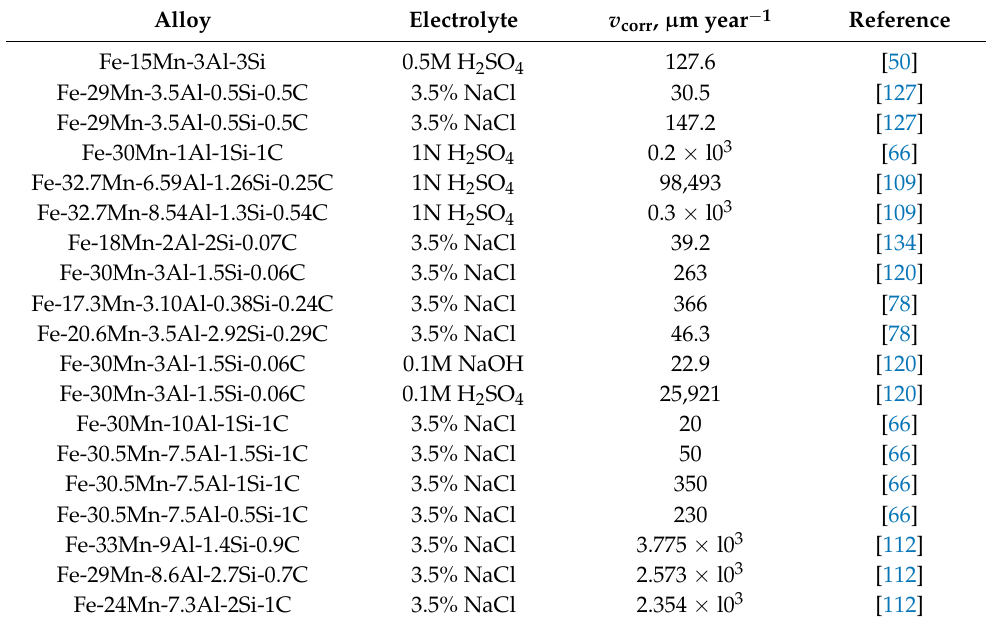
Table 4. Corrosion rate ( v corr ) ( µ m year − 1 ) values for high-Mn TWIP steels with aluminum and silicon